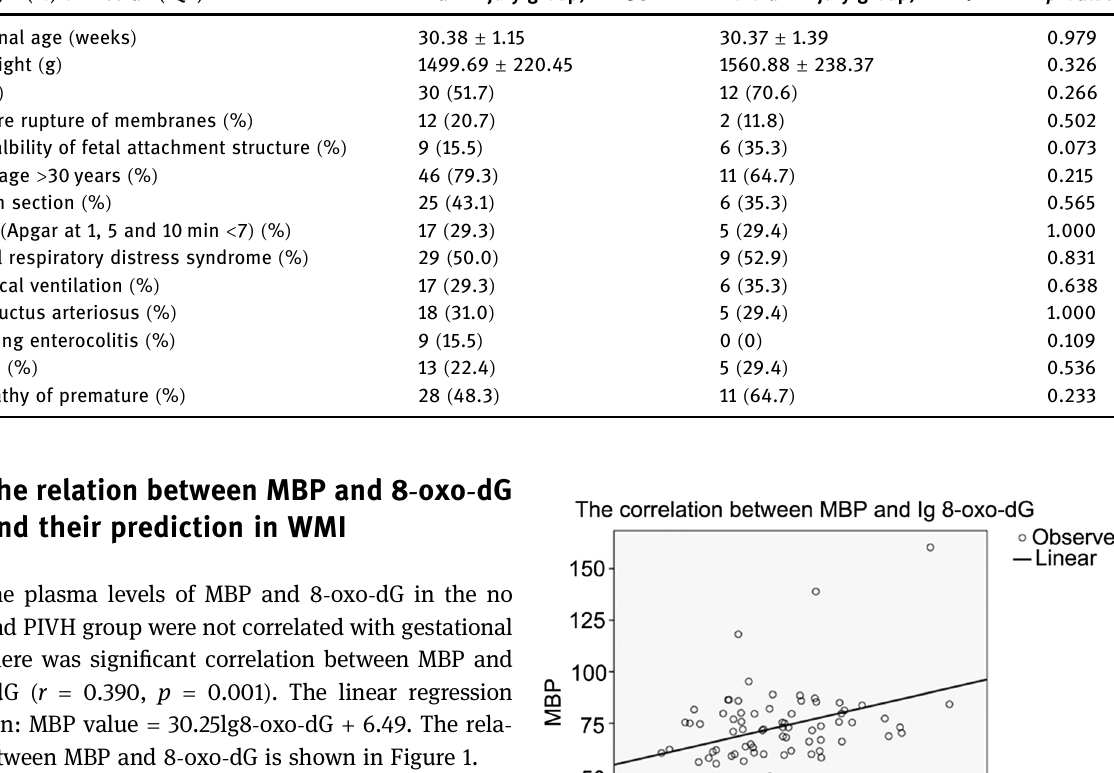
Table 1: Clinical characteristics of cases with brain injury Variable, n ( % ) or median ( IQR )